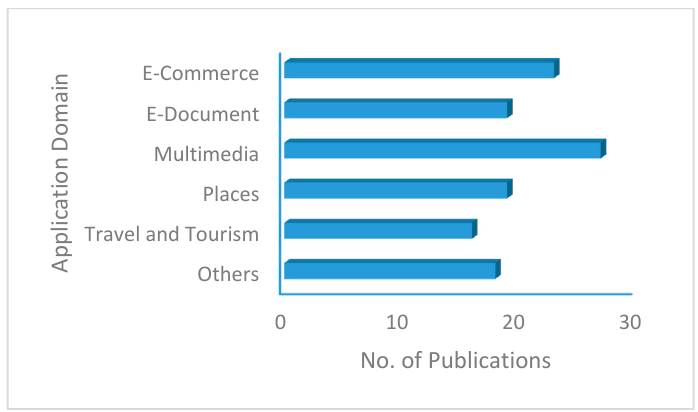
Figure 3. Classification by domain of application.